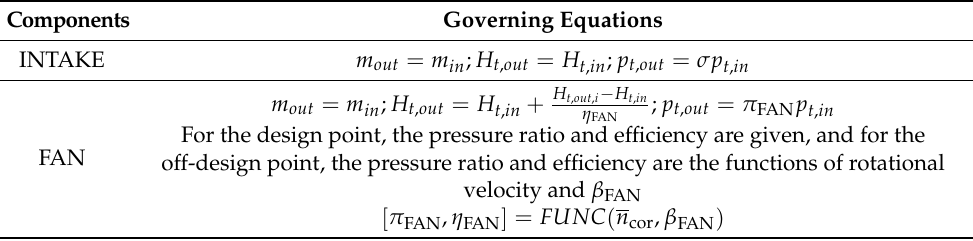
Figure 4. The schematic of engine simulating model. Table 3. The governing equations of each